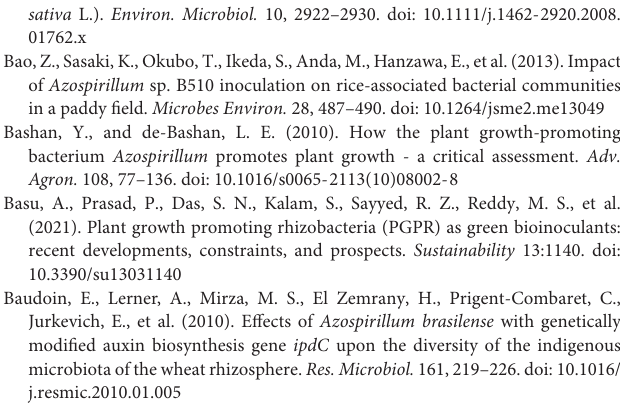
Supplementary Figure 1 | Rarefaction curves for nifH (A) , acdS (B) , and rrs (C) at field sites L, FC, and C. NI and I correspond, respectively, to non-inoculated and inoculated conditions. Supplementary Figure 2 | Non-metric multidimensional scaling (NMDS) of nifH (A) , acdS (B) , and rrs (C) data at field sites L, FC, and C. NI and I correspond, respectively, to non-inoculated and inoculated conditions. NMDS of distance matrices was based on the Bray–Curtis distance and was done using the vegan package in R. Supplementary Figure 3 | Relative abundance of the most prevalent bacterial genera based on analysis of nifH , acdS and rrs data for field sites L, FC, and C (results from the five replicates were pooled). NI and I correspond, respectively, to non-inoculated and inoculated